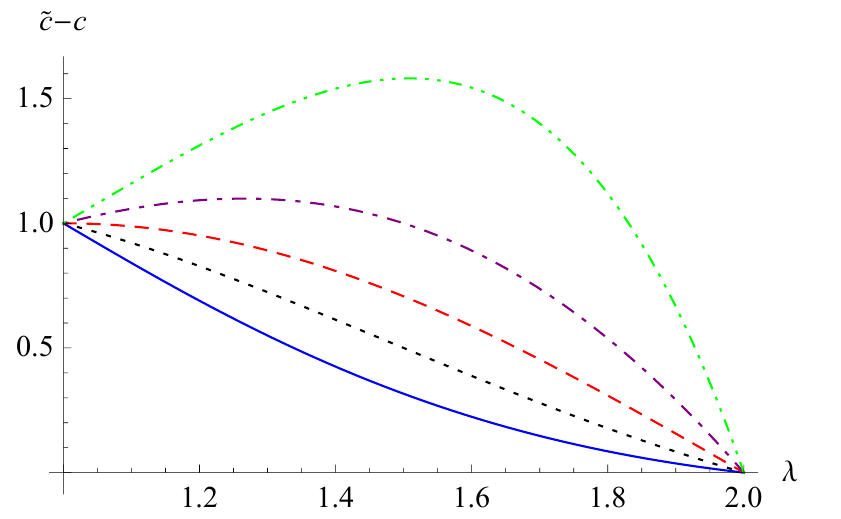
Figure 1. The curves of ˜ c − c versus λ for η = 1 and for ω = 0.2 (solid line), 0.5 (dotted line), 1 (dashed line), 2 (dot-dashed line), and 5 (dot-dot-dashed line).